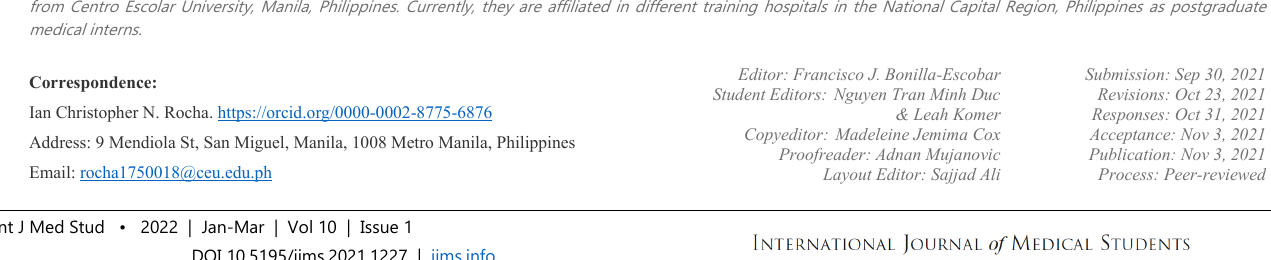
and a drive-thru site